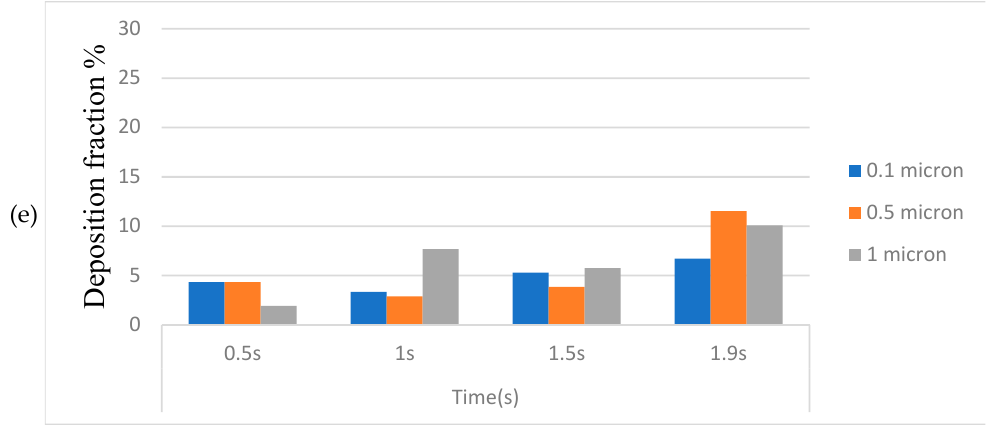
Figure 14. ( a ) Smoke particle deposition in the oropharynx; ( b ) Smoke particle deposition in the trachea; ( c ) Smoke particle deposition in first-bifurcation junction; ( d ) Smoke particle deposition in left bronchus; ( e ) Smoke particle deposition in right bronchus.